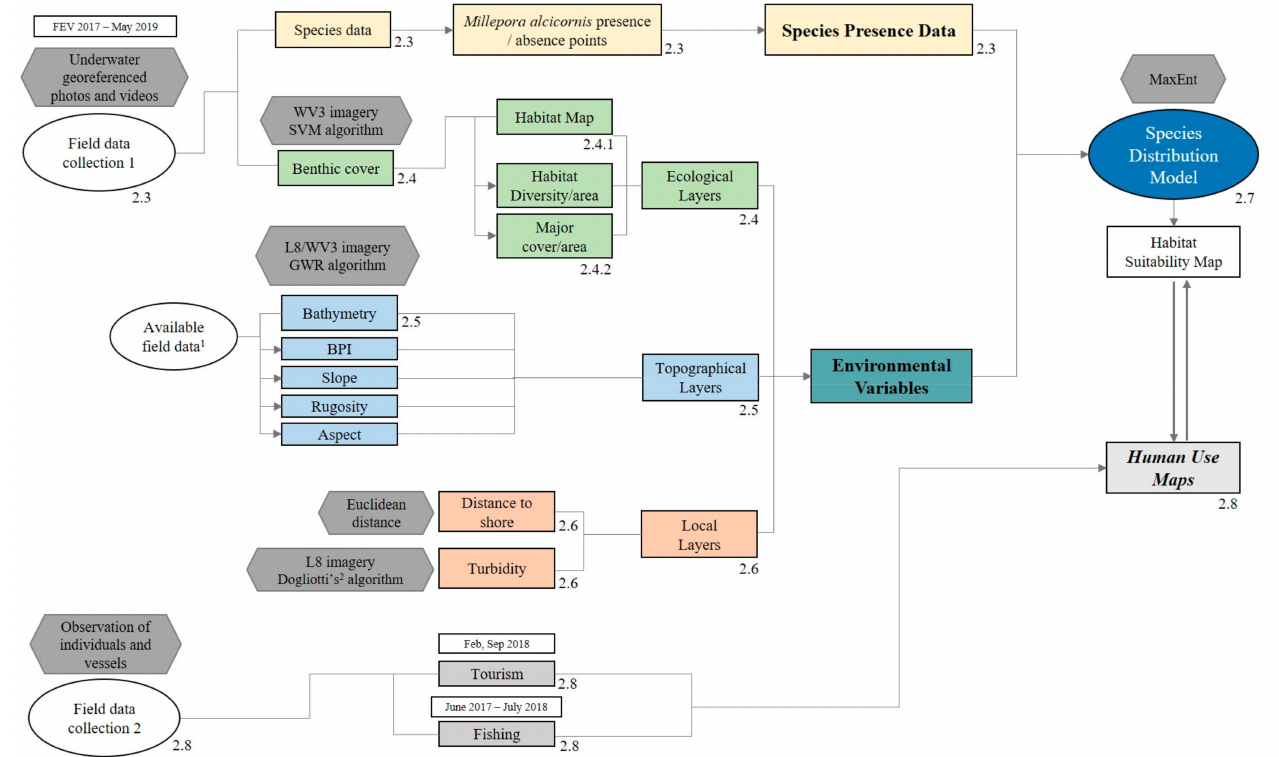
Figure 2. General workflow of the methodology and expected resulting layers in the present study. Field surveys and dates in which each survey was conducted are represented by white circles and white rectangles, respectively; the methodology, satellite imagery and/or algorithm used in each specific step are represented by grey hexagons; layers related to species presence data (yellow rectangles), ecological variables (green rectangles), topographical variables (blue rectangles) and local layers (orange rectangles) used as input in the species distribution model (SDM) are also shown; use layers are represented by grey rectangles. The number on the bottom right of each step corresponds to the subsection in which it is